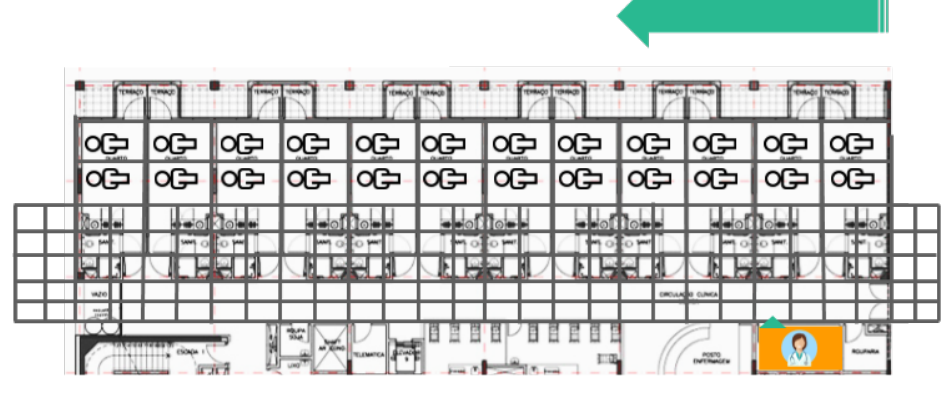
Figure 11. Grid map of the simulated